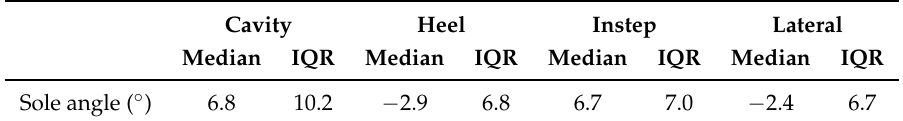
Table 4. Median error and IQR of the error for the parameters sole angle without the bias correction for